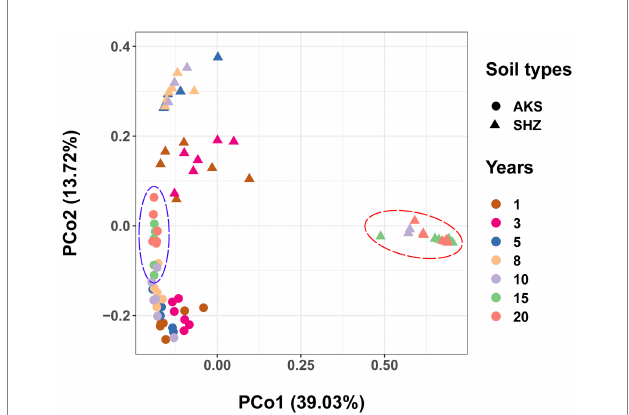
FIGURE 2 Principal coordinate analysis (PCoA) based on Bray-Curtis distance for the bacterial community structure of cotton field soil samples with different continuous cropping years in AKS and SHZ soils.